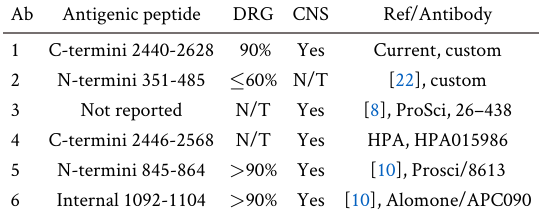
Table 1. Antigenic peptides used to generate anti-PIEZO2 antibodies and their staining of DRG and brain